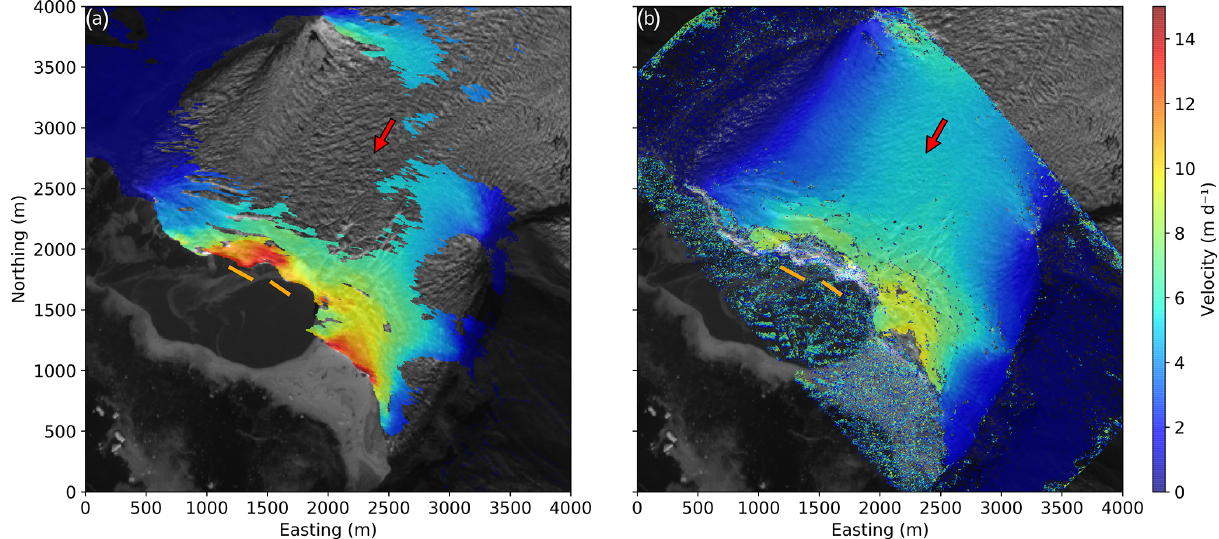
Figure 5. The velocity field at the glacier front. (a) Measured with the TRI (line of sight) on 19 August 2016 and (b) with an UAV (between 21 and 25 August 2016; Rohner et al., 2019). The red arrow indicates the general flow direction. The orange lines indicate an area where bedrock was observed at the foot of the front. The origin of the coordinate system corresponds to 7741550 ◦ N, 528350 ◦ E (UTM 22N). Background: Sentinel-2A scene from 3 August 2016 (from ESA Copernicus Science Hub: https://scihub.copernicus.eu, last access: 14 August